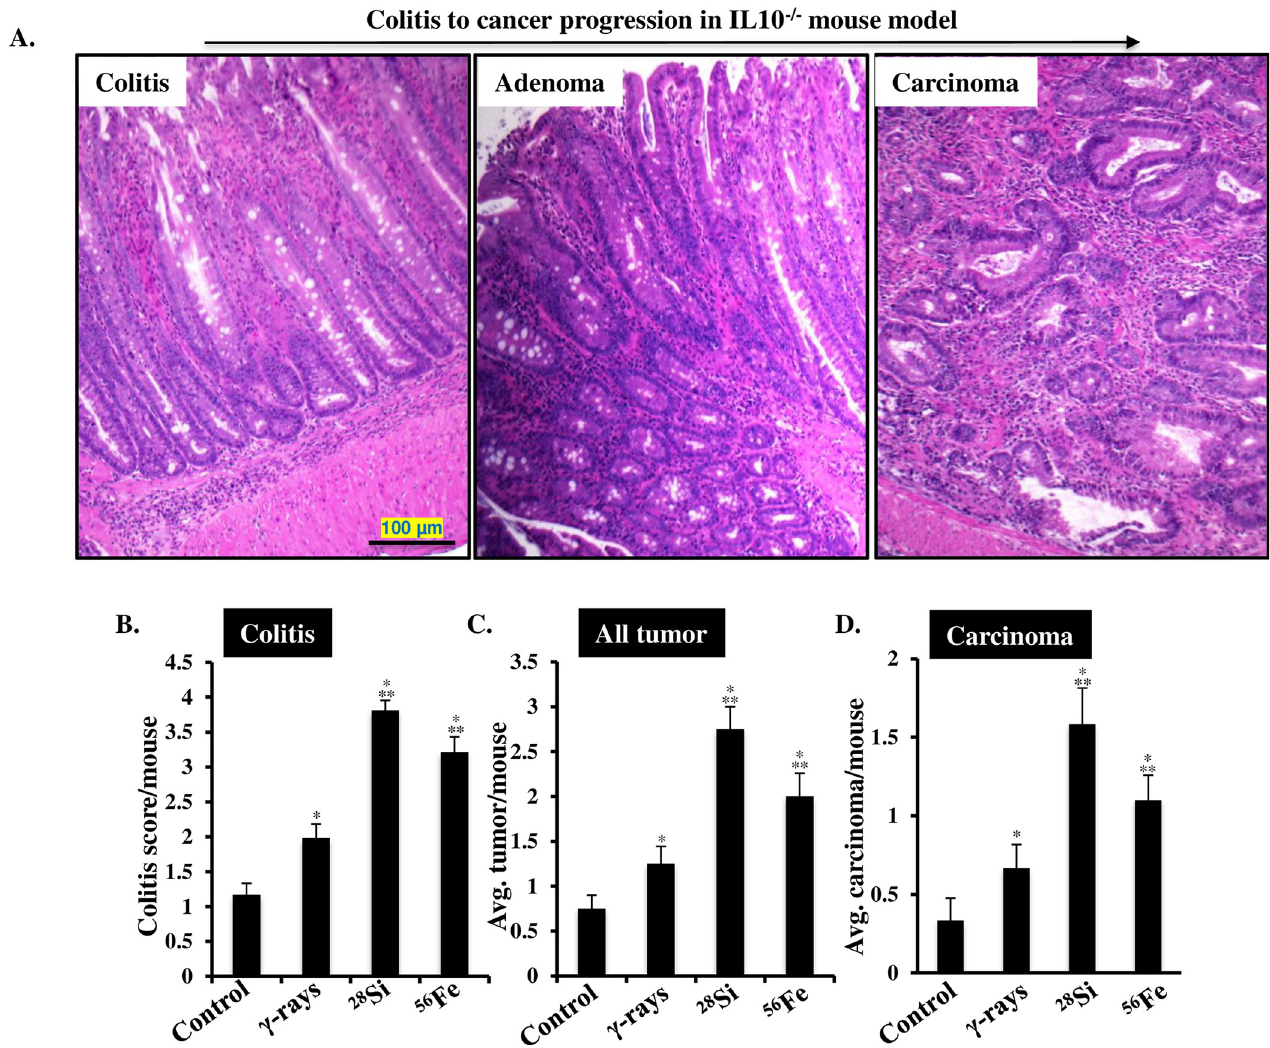
Fig 2. Heavy-ion exposure induced colitis and colon cancer in Il10 -/- mice. A) Representative H&E-stained images (100X magnification) of colitis, adenoma, and carcinoma in Il10 -/- mice. B) Induction of colitis after exposure to equitoxic doses of γ (2 Gy), 28 Si (1.4 Gy), and 56 Fe (1.6 Gy) at 2.5 months post-exposure. Colitis was scored on a scale of 0 to 4 and the average colitis score has been presented as a bar graph. C) The average number of colonic tumors at 2.5 months after γ , 28 Si, and 56 Fe exposure. D) The average number of carcinomas at 2.5 months after γ , 28 Si, and 56 Fe exposure. All bars show mean ± SEM and � indicates a p-value < 0.05 compared to control and �� indicates p < 0.05 compared to the γ exposed